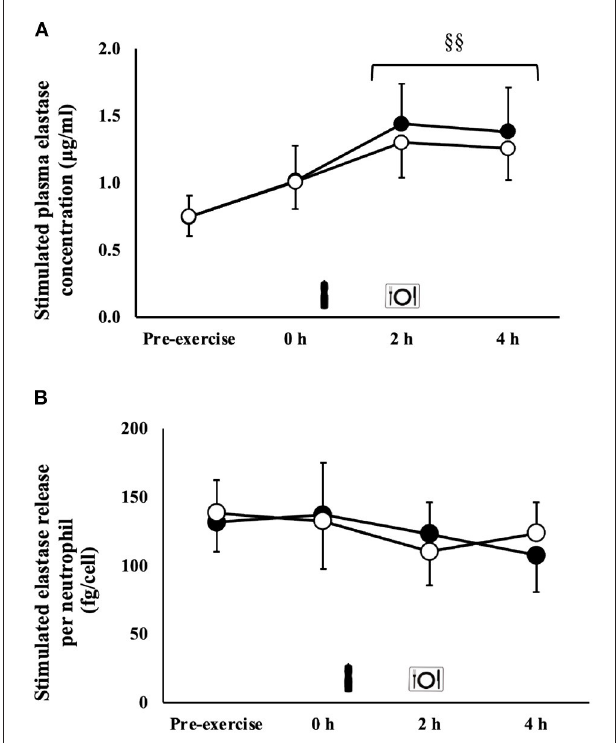
FIGURE 4 | Total (A) and per cell (B) bacterially-stimulated neutrophil elastase release after 2h HIIT exercise in temperate ambient conditions and consumption of a whole food dairy milk (CM: (cid:4) ) and a reconstituted milk based supplement (MBSB: ◦ ) recovery beverage. Mean ± SEM ( n = 9): MEOTime §§ P < 0.01 vs.